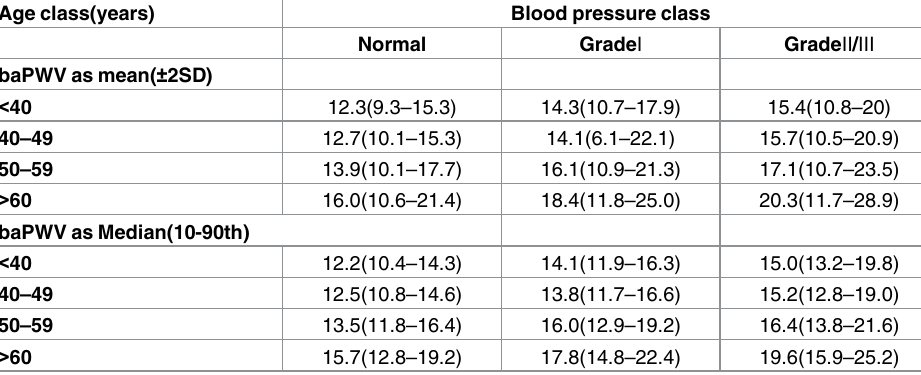
Table 5. Referencevalue of baPWV(m/s) according to age and blood pressure.